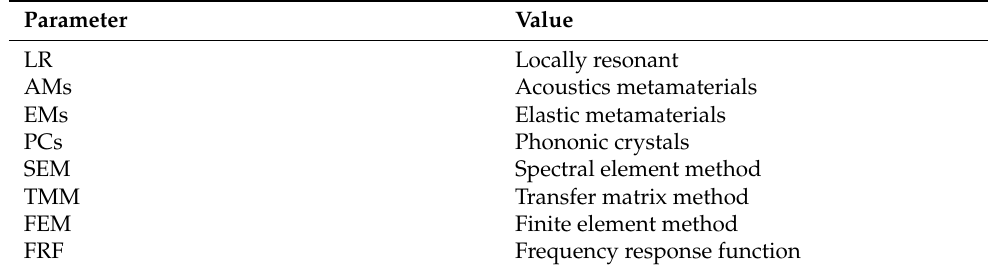
Table 2. List of key acronyms used in this